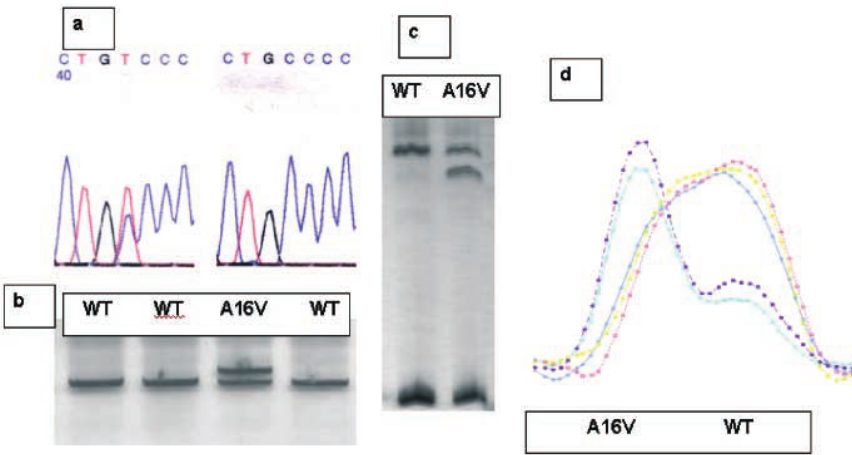
Different techniques for analysis of PRSS1 mutations, ie A16V. a. Direct DNA fluorescence sequencing (left, heterozygote; right, wild-type). b. Restriction fragment length polymorphism (RFLP) analysis using Fnu4H I. c. Single strand conformation polymorphism (SSCP) analysis. d. Melting curve analysis using fluorescence energy transfer (FRET)